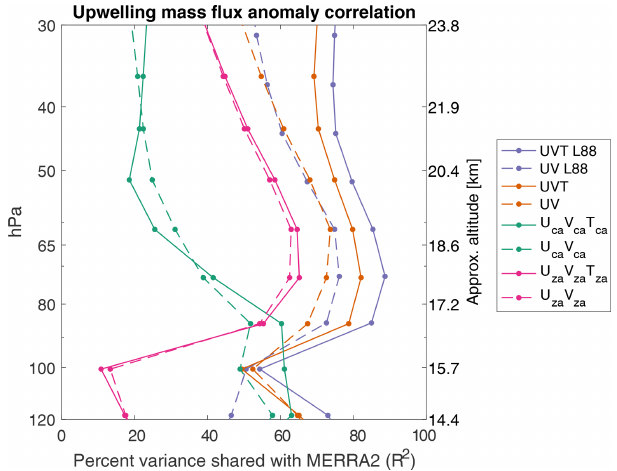
Figure 6. Correlation of tropical upwelling mass flux anomalies be- tween each simulation and